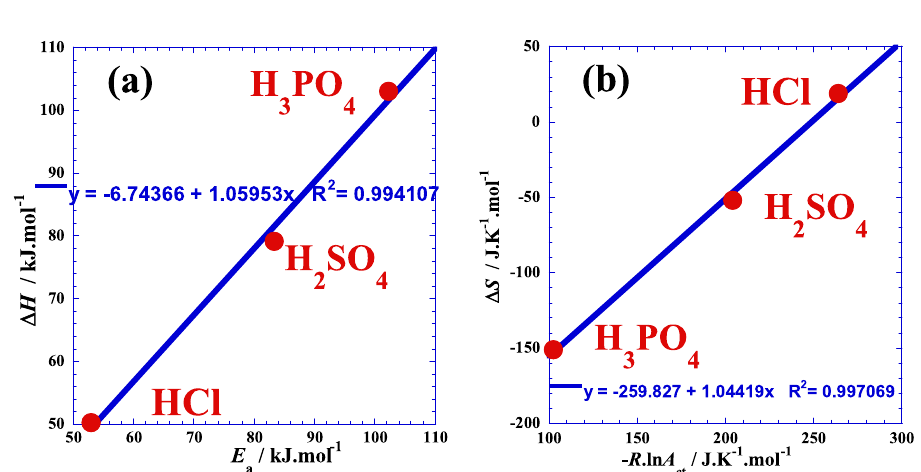
Figure 3. Correlation between the entropic factor of Arrhenius – R ·ln( A ct /Ω·cm 2 ) / (J/K·mol) and the thermodynamic parameters for glassy Ni 82.3 Cr 7 Fe 3 Si 4.5 B 3.2 alloy corrosion; ( a ): with the activation enthalpy Δ H (kJ/mol) and ( b ): with the activation entropy Δ S (J/K·mol) determined from impedance measurements in previous work 21 for the three polyacids HCl, H 2 SO 4 and H 3 PO 4 at atmospheric pressure.